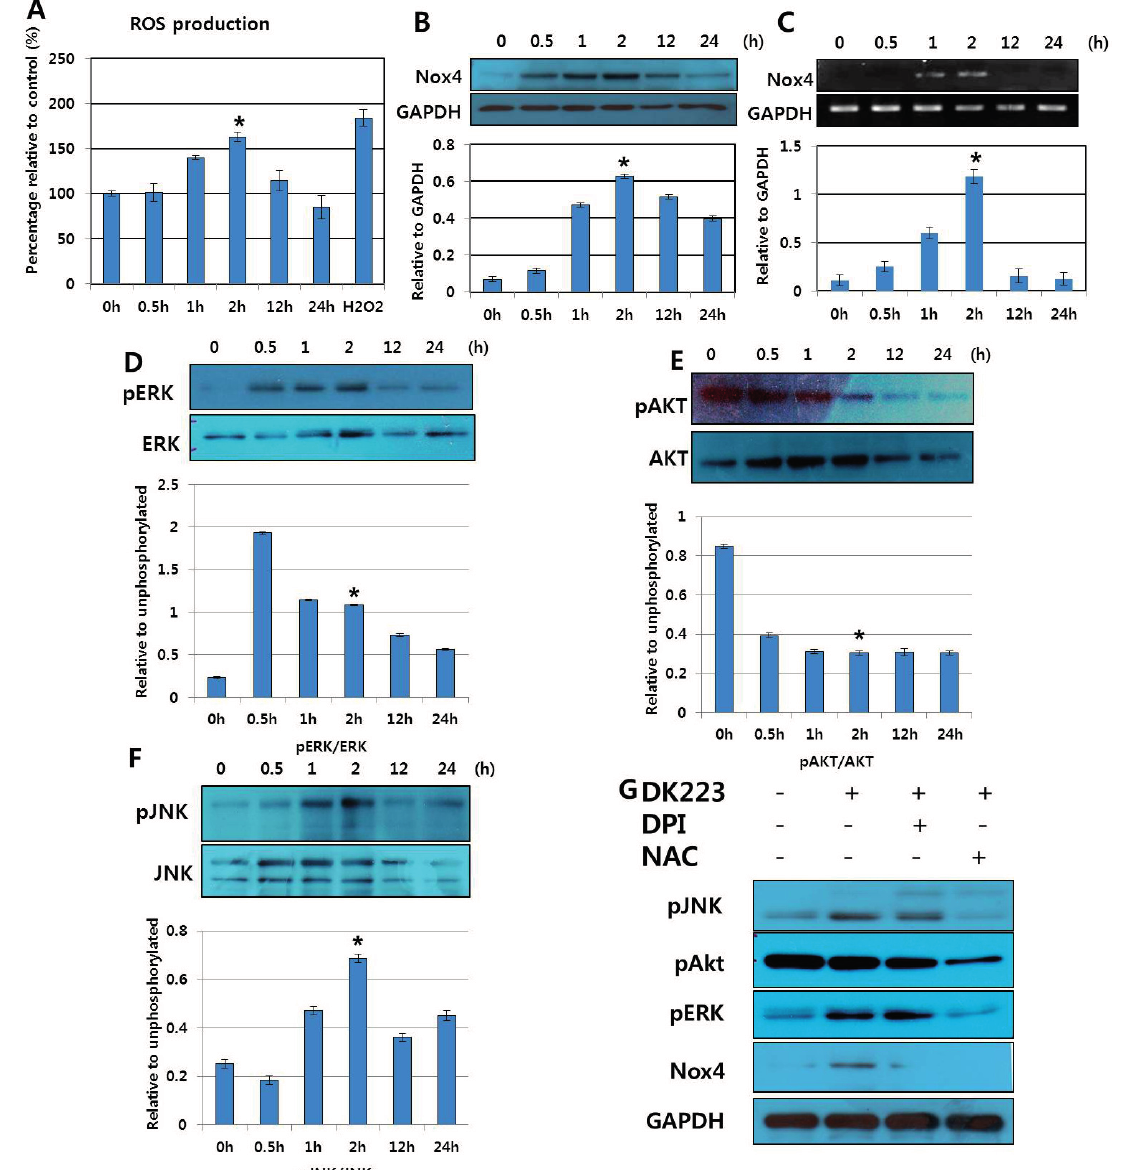
Figure 3. Time-dependent expression of NAPDH oxidase, ROS accumulation and signaling pathways in HaCaT cells after treatment with DK223. ( A ) Time- dependent ROS generation was detected in treated HaCaT cells using the DCF-DA assay. Cells were treated with 2 μ M DK223 at different times and then stained with DCF-DA to detect ROS generation, as described previously. H O was used as a positive control; ( B , C ) The expression of NAPDH 2 2 oxidase 4 was examined by Western blot and RT-PCR, as described previously; ( D – F ) Signaling pathways were examined by Western blot with the specific antibodies indicated; ( G ) Cells were pretreated with 10 μ M DPI or 20 μ M NAC for 2 h before 24 h DK223 incubation. Signaling pathways were examined by Western blot with the specific antibodies indicated; ( H ) Cells were seeded at a density of 3 × 10 4 /mL 24 h before the scratch test. Scratch widths were measured 48 h after DK223 treatment only or co-treatment with 10 μ M DPI or 20 μ M NAC. A histogram shows the results of ImageJ data analysis. Values represent means ± SD of three independent experiments, * p < 0.05 in all under